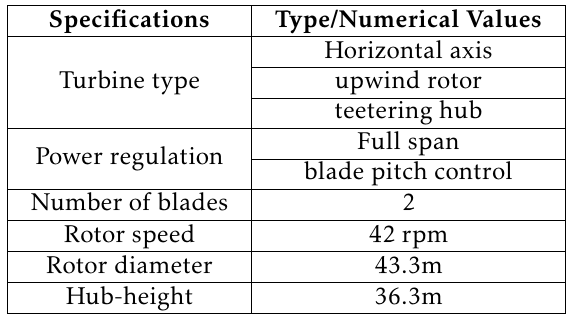
Table 1. General specifications of the CART2 HAWT